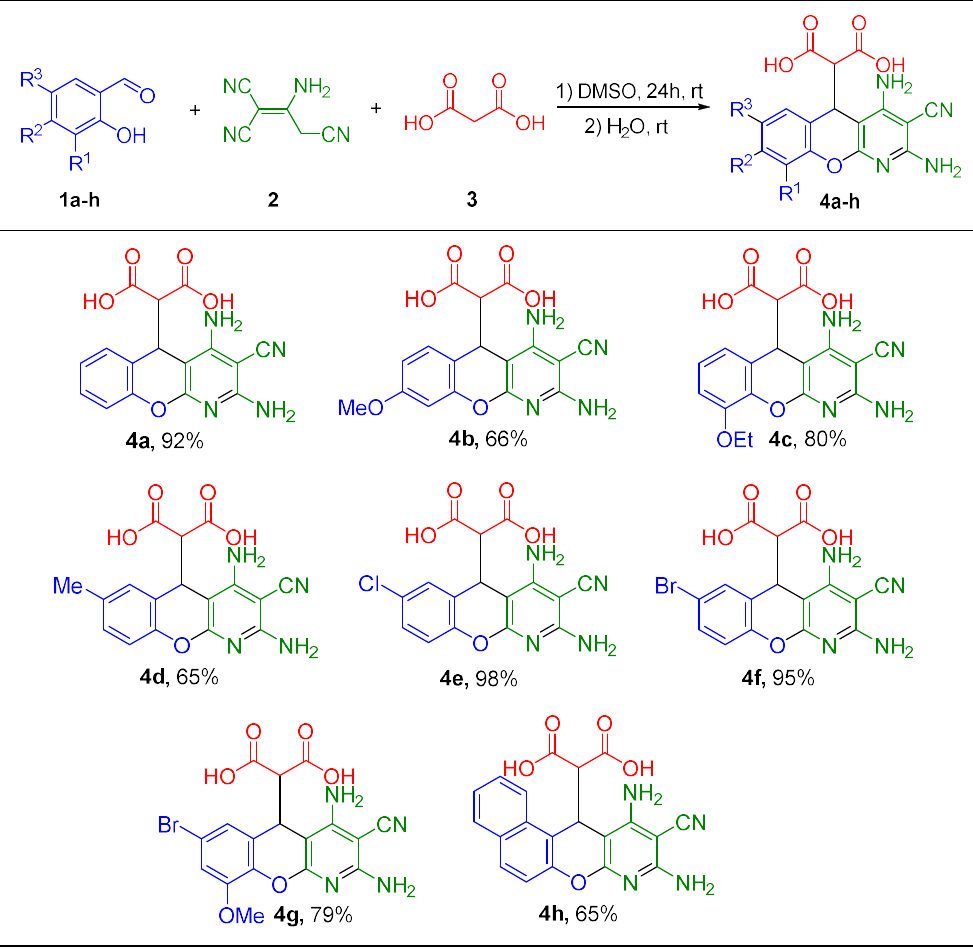
Table 2. Multicomponent reaction of salicylaldehydes 1a – h , malononitrile dimer 2 and malonic acid 3 1 .